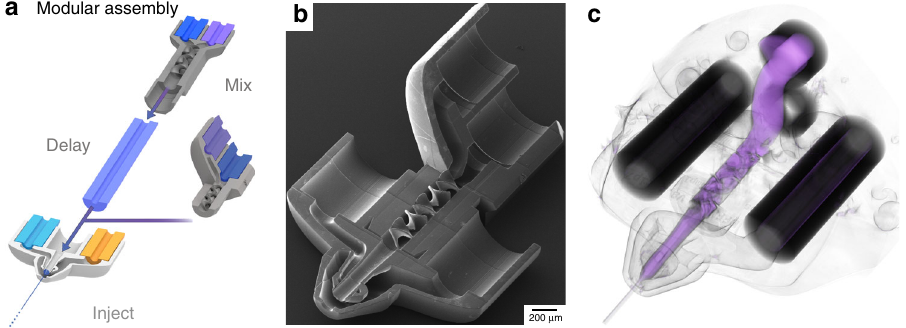
Fig. 6 Modular mixer assembly. a Our 3D mixer seamlessly combines with our different nozzle designs. Adjusting delay line lengths result in select time delays from reaction initiation prior to X-ray imaging. Direct insertion of the mixer into the nozzle minimizes the delay for very short time delays on the order of a few milliseconds (Supplementary Fig. 15). b SEM image of the 3D mixer integrated with the DFFN nozzle (Design 8, 12). c Tomographic reconstruction of the 3D mixing-nozzle assembly running at fl ow rates 40 μ l min − 1 each, corresponding to a 3 ms time delay, from the mixer exit to the jet X-ray interaction region. Liquid mixing and jetting are highlighted using false coloring for respective liquid absorption X-ray gray